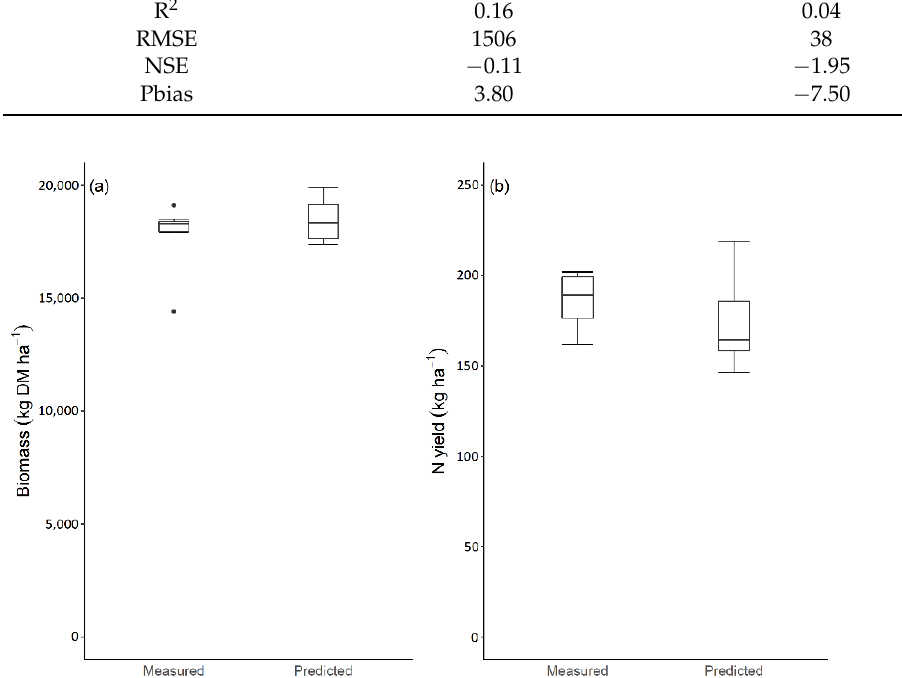
( n = 7). Figure 2. Measured and predicted values for forage maize biomass (DM) ( a ) and N yield ( b ) at E1 ( n = 7).